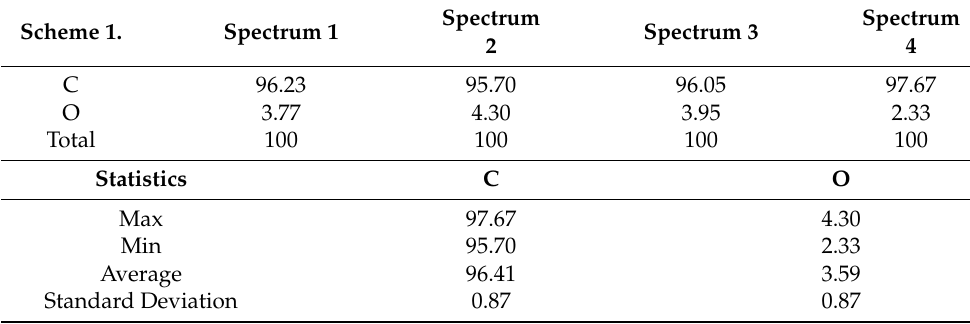
Table 1. Composition of the formed SWCNTs clusters.